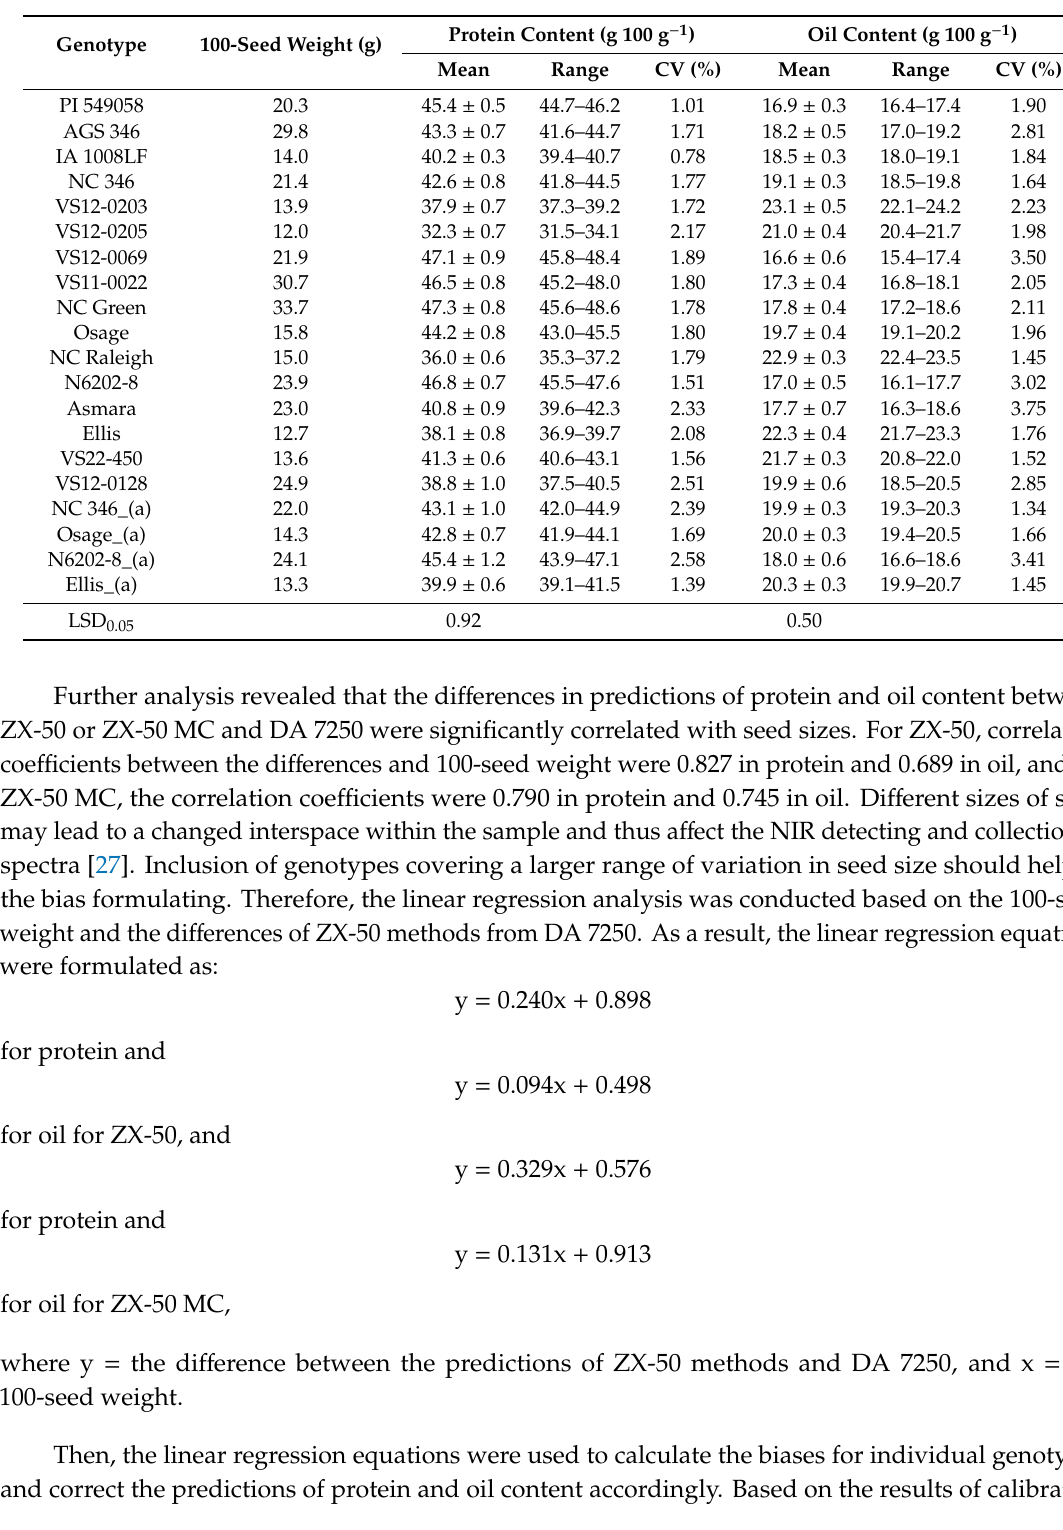
Table 3. Hundred-seed weight, and means and variations of protein and oil content determined using DA 7250 NIR analyzer in 20 soybean genotypes /